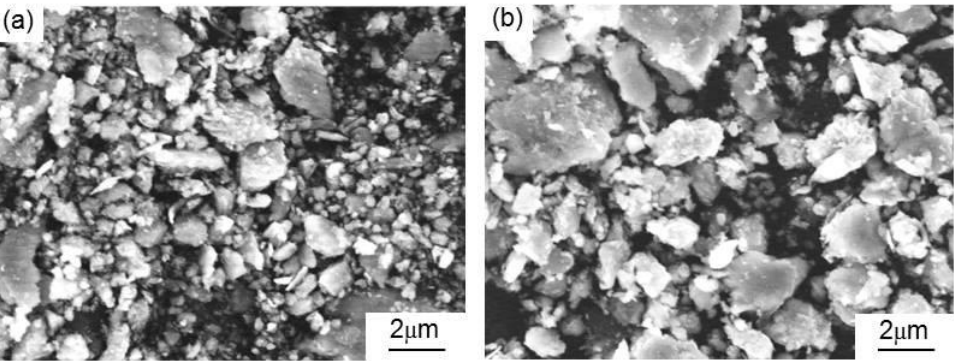
Figure 9. SEM images of the graphite debris of ( a ) the MCMB–Cu composites and ( b ) the GrF–Cu